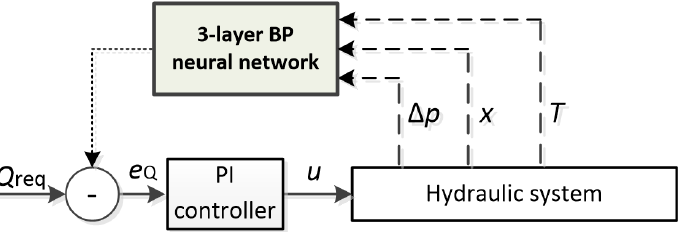
Figure 10. Flow control system of a proportional valve by [36]; Q req —required flow rate, e Q —control error, u —control signal, ∆ p —pressure drop, x —valve spool position, T